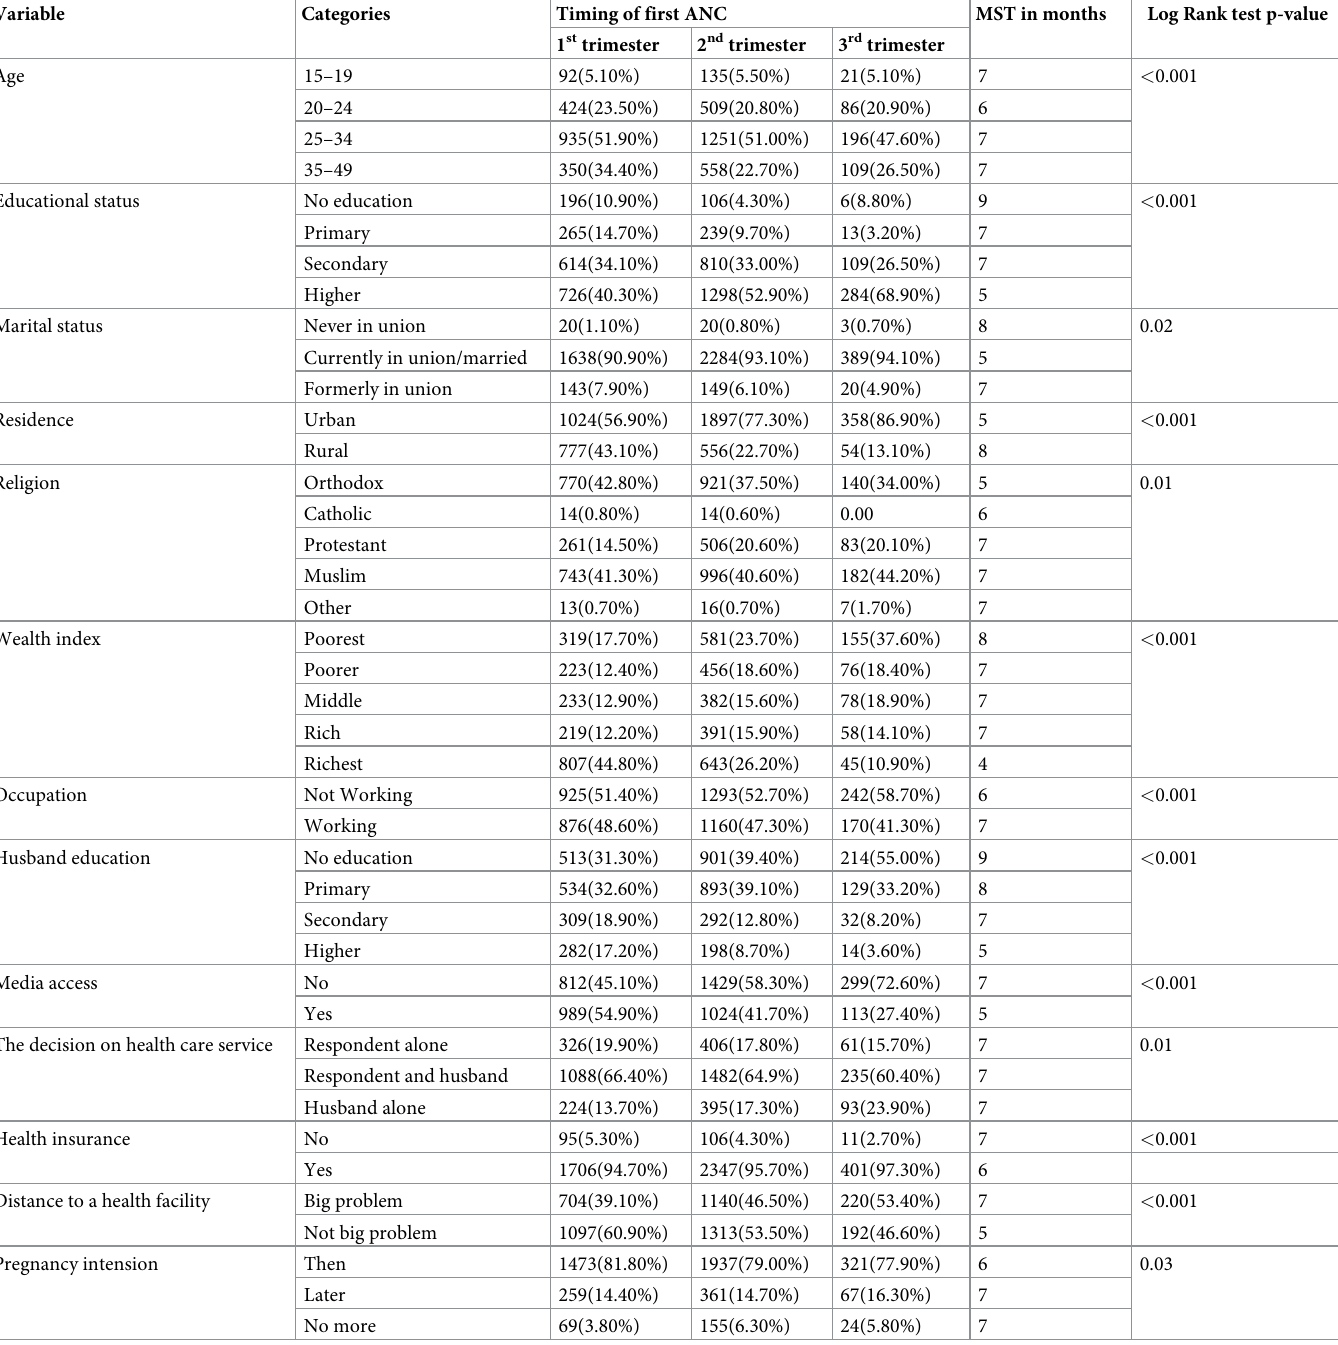
Table 1. Percentage of study participants by their characteristics, median survival time, and log-rank test concerning the timing of the first ANC visit (n = 4666).